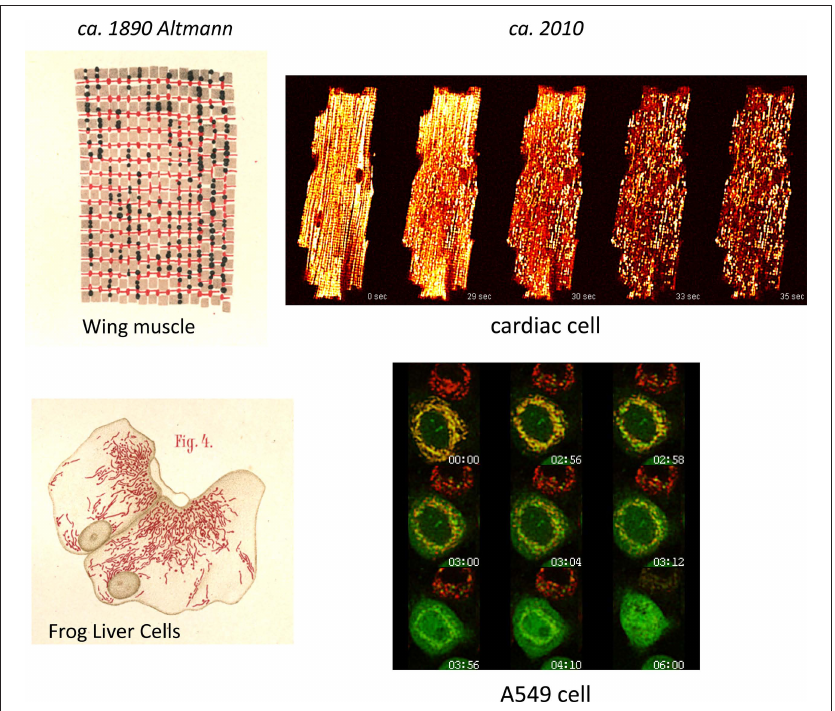
Figure 1 | Mitochondrial network imaging in the 19th and 21st centuries. Left panels show histological drawings of “bioblasts” in flight muscle (upper) and liver (lower) cells as described by Altmann (1890). Right panel illustrates spatiotemporal changes in Dψ in the mitochondrial network following oxidative stress in a m canine ventricular myocyte (upper), and in an A549 lung carcinoma cell (lower), which was also transduced with a cytochrome C-green fluorescent protein fusion construct. The fluorescent potentiometric dye tetramethylrhodamine ethyl ester (TMRE) was used to image Dψ in both cases (red images). Note the m spatial synchronization of depolarization in the cardiac cell. Overlay of the Dψ and cytochrome C images m (yellow) reveals that Dψ loss and cytochrome C release occurred within a similar time frame (approximately m at 2 hours and 58 minutes as indicated on the image frames). Please see accompanying